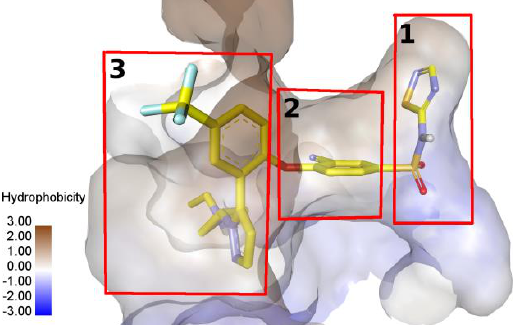
Figure 3. Structure of the Nav1.7 antagonist binding site. The antagonist GX-936 is shown with a yellow structure. The numbers indicate: 1—anion-binding pocket, 2—selectivity pocket, 3—lipid- exposed pocket.